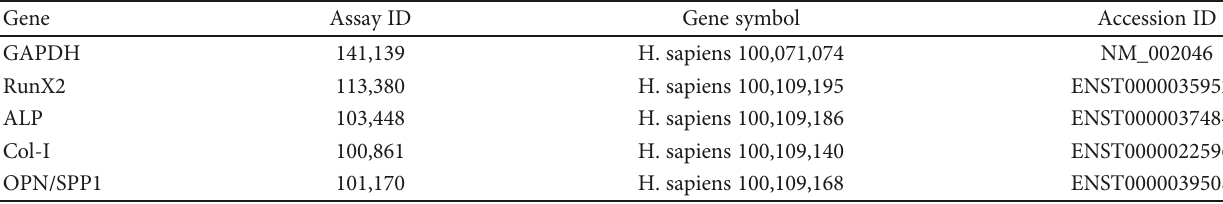
Table 1: Primer names and ID used for real-time PCR (supplied by